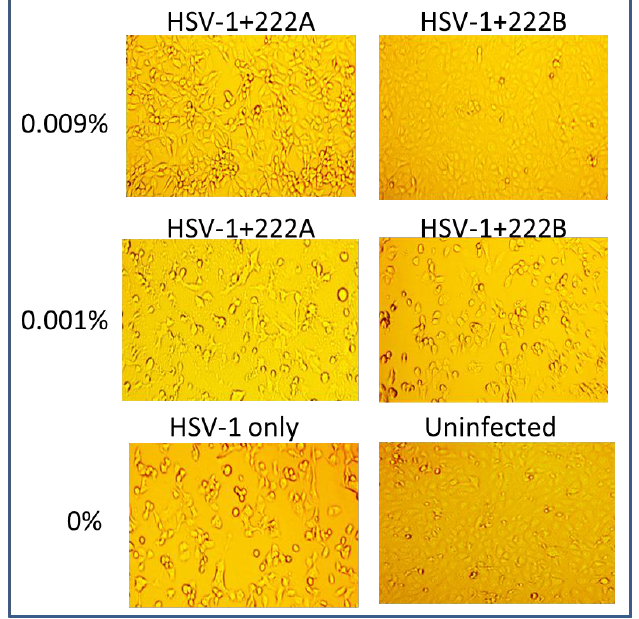
Figure 1. HSV-1 infected Vero cells in the presence or absence of rhamnolipids. The concentration of rhamnolipids is indicated on the left of the images. HSV-1 infection with 222A or 222B is labeled above the image as HSV-1+222A or HSV-1+222B. Vero cells were infected with ~2 × 10 6 FPU/well, and the images were taken at 24 hpi at 10 × magnification.